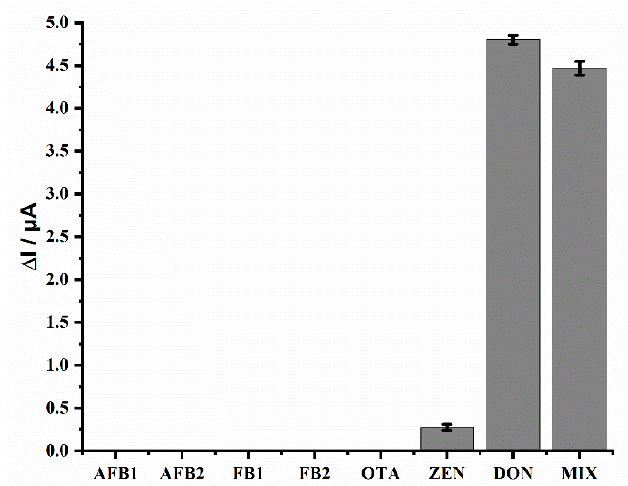
Figure 5. Selectivity of the electrochemical aptasensor in the detection of DON. The concentration was 2 ng mL − 1 for all mycotoxins. MIX represents a mixture of multiple mycotoxins: AFB1+ AFB2+ FB1+ FB2+ OTA+ ZEN+ DON. Table 1. Comparison of DON determination using different electrochemical sensors.